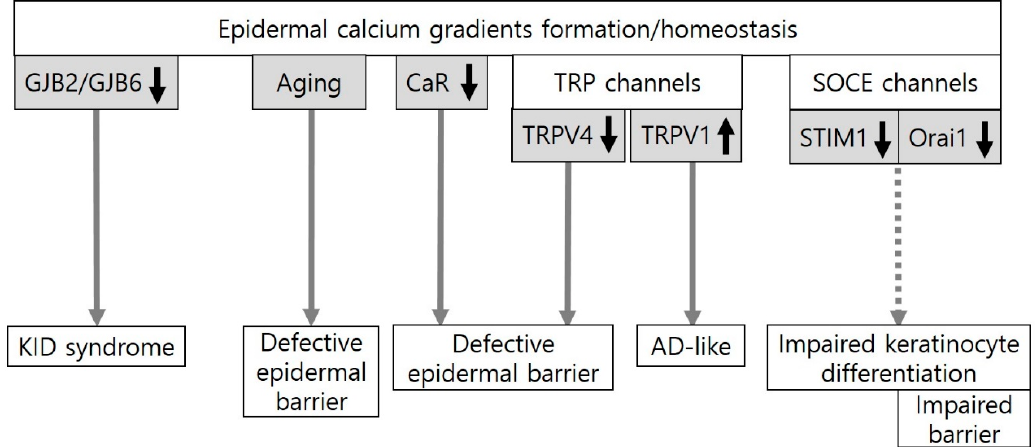
Figure 1. An evidence-based or potential association between epidermal calcium gradients and the epidermal barrier. Epidermal calcium gradients have been altered in keratitis-ichthyosis-deafness (KID) syndrome induced by gap junction protein beta 2 (GJB2) or GJB6 missense mutations and in chronological skin aging. The formation and homeostasis of the epidermal calcium gradients could be regulated by the calcium-sensing receptor (CaR), transient receptor potential (TRP) channels, and store-operated calcium entry (SOCE) channels. CaR deletion, which inhibits Ca 2 + influx, impairs the epidermal barrier in mice. In TRP channels, TRP vanilloid 4 (TRPV4) activation, which could be induced by heat ( > 30 ◦ C) and hypo-osmolarity, plays an important role in epidermal barrier formation and recovery in mice. On the other hand, the blockade of TRPV1 activation by physical and chemical stimuli such as heat (42 ◦ C) and capsaicin can suppress atopic dermatitis (AD)-like symptoms in mice. Two essential components of SOCE, STIM1 (stromal interaction molecule1) and Orai1 (ORAI calcium release-activated calcium modulator 1), are activated by endoplasmic reticulum (ER) calcium store depletion. Downregulation of Orai1 can impair keratinocyte differentiation and barrier homeostasis in mice.